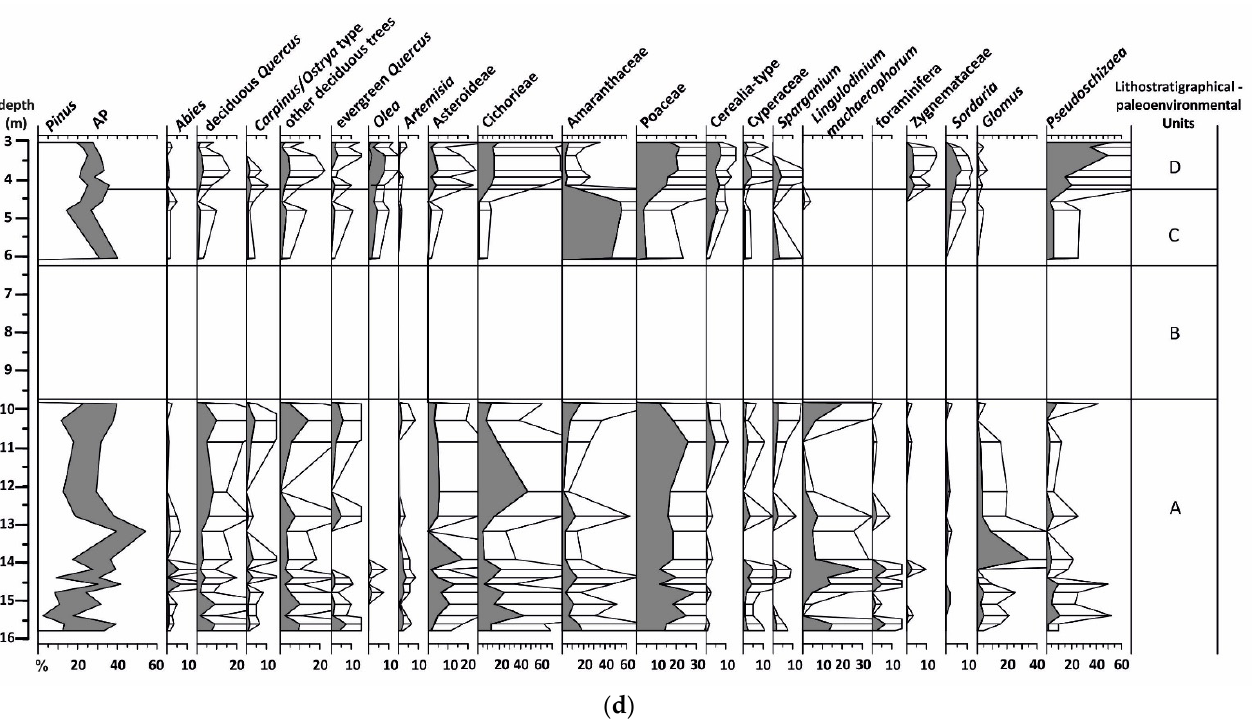
Figure 4. ( a ) Distribution of foraminiferal and ostracod indices along borehole P4 in respect to lithostratigraphic units; ( b ) Relative abundances of the major benthic foraminiferal and ostracod species in borehole P4; ( c ) Distribution and semiquantitative analysis of the main mollusc taxa and other microscopic findings in borehole P4; ( d ) Relative abundances (exaggeration ×10) of the most important pollen and other palynomorph assemblages in borehole P4. Lithostratigraphic units (A–D) are separated by dotted lines.